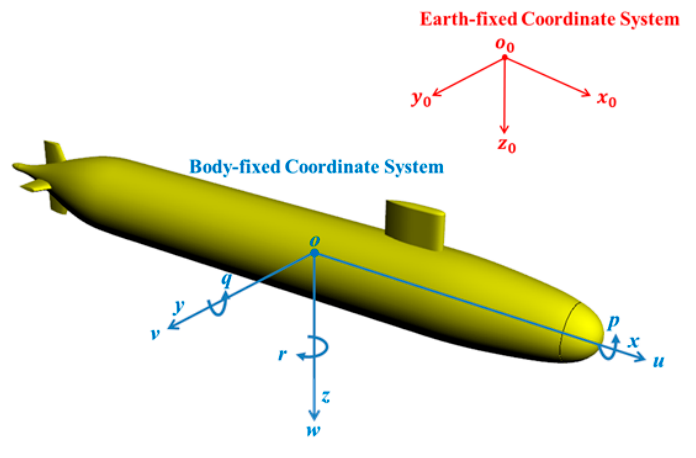
Figure 2. Schematic diagrams of coordinate systems. Table 1. Parameters of the six degree of freedom (DOF) motion modes of the submerged body.